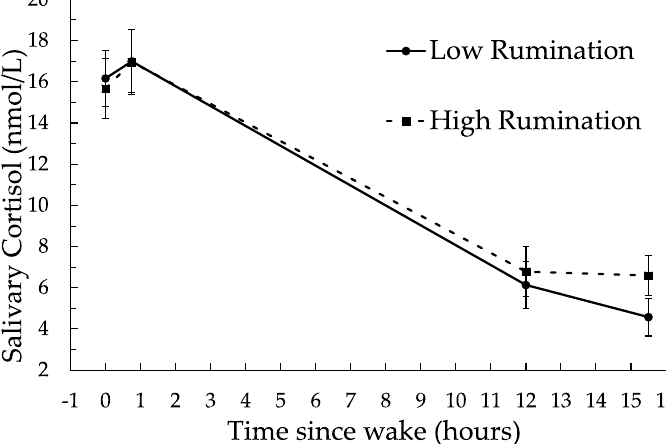
Figure 1. Diurnal salivary cortisol as predicted by trait rumination. Data points shown are estimated means (along with standard errors of mean estimates) for high (+1 SD ) and low ( − 1 SD ) levels of rumination. Precise sampling time guidelines were provided for samples taken at wake, 45 min post-wake, 12 h post-wake, and at bedtime ( M = 15.5 h post ‐ wake).